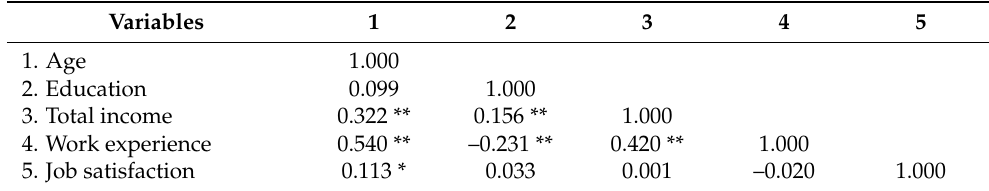
Table 9. Matrix displaying bivariate correlations between some selected independent variables (respondent age, education, total income, and work experience) and one dependent variable: job fulfillment (N = 350).